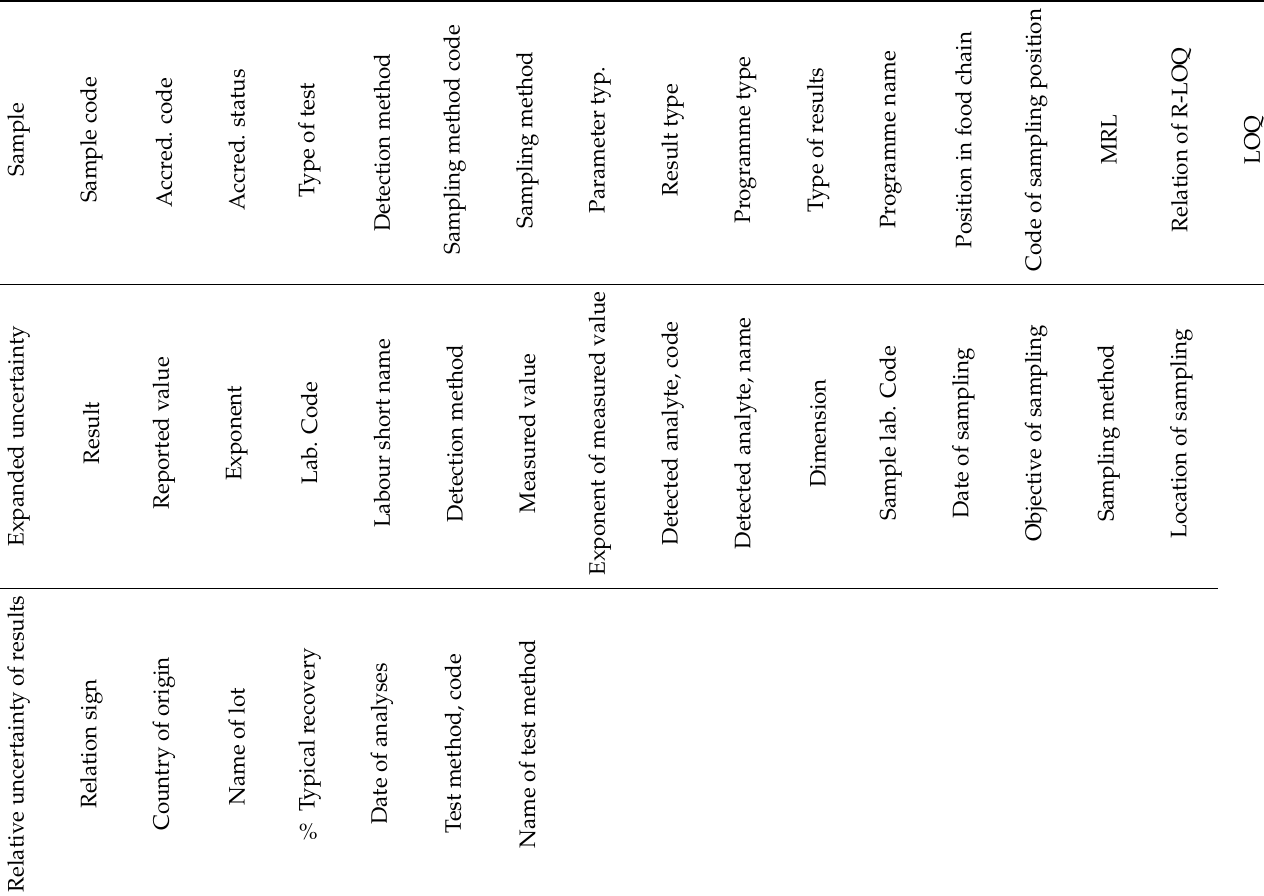
Table A1. Information to be provided to EFSA on results of residue analyses 1